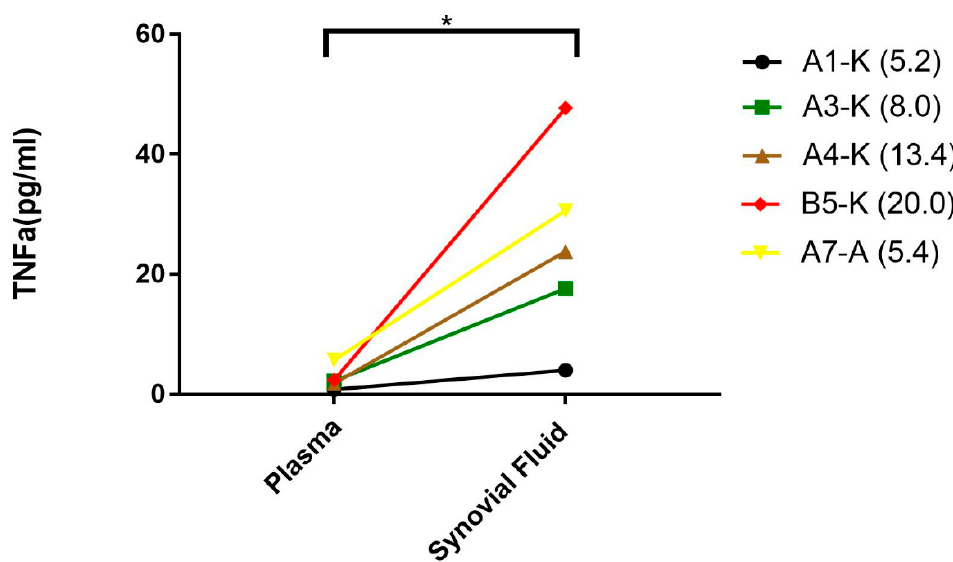
Figure 5. Elevated levels of TNF α in the synovial fluid of patients with hemophilic arthropathy. Plasma and synovial fluid were collected from hemophilia patients with hemophilic arthropathy to measure TNF α levels. Values in parentheses represented the ratios of TNF α level between the synovial fluid and plasma. * p < 0.05.